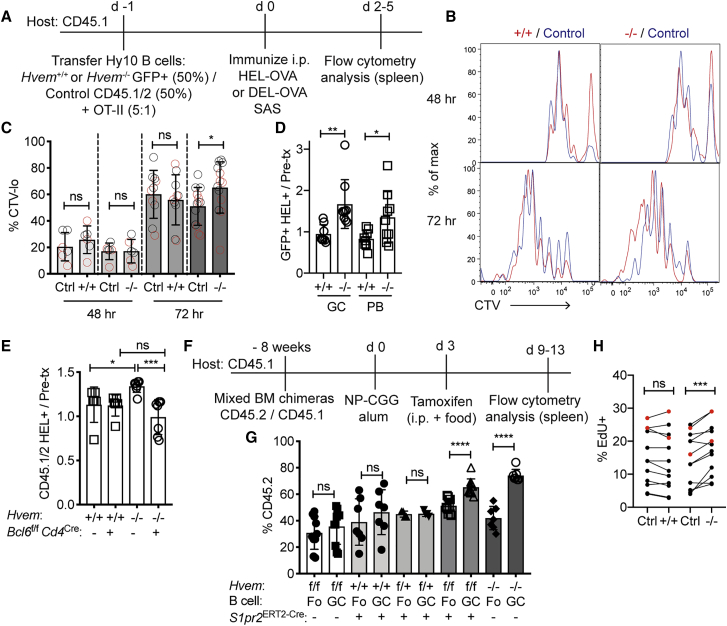
HVEM Deficiency Provides B Cells with a Proliferation Advantage Early in the Response and within the GC(A) Experimental scheme and timeline for experiments in (B)–(D). CD45.1/2 indicates cells from mice carrying both a CD45.1 and a CD45.2 allele. SAS indicates Sigma Adjuvant System.(B) Representative CTV dilution at 48 and 72 hr of Hy10 B cells compared with co-transferred WT Hy10 B cells after DEL-OVA immunization. Hvem+/+ or Hvem−/− Hy10 is in red, and WT mixing partner (control) is in blue.(C) Frequency of CTV-diluted (defined as more than three divisions at 48 hr and more than four divisions at 72 hr) Hy10 B cells compared with their WT mixing controls. Gray circles indicate HEL-OVA immunization, and red circles indciate DEL-OVA immunization. Data are pooled from three experiments.(D) Ratio of the frequency of GFP+HEL+ GC B cells or PBs at days 4.5–5 after HEL-OVA immunization to the pre-transfer frequency of GFP+HEL+ B cells. Data are pooled from three experiments with pre-transfer mixtures of ∼20%–60% GFP+ cells.(E) Mixed Hy10 transfer with endogenous T cell response into Bcl6f/fCd4Cre hosts and 2×-HEL SRBC immunization. The ratio of the frequency of CD45.1/2 Hvem+/+ or Hvem−/− Hy10 to the pre-transfer frequency is shown. Tfh-cell-deficient (Bcl6f/fCd4Cre) and control hosts were analyzed at days 5–7. Data are pooled from three experiments.(F) Experimental scheme and timeline for experiments in (G).(G) Frequency of CD45.2 Fo and GC B cells in the tamoxifen-treated mixed BM chimeras. Data are pooled from three experiments and include chimeras with 10%–60% CD45.2 Fo B cells.(H) Frequency of EdU+IgDloEphrinB1+ GC B cells in Hvem+/+ and Hvem−/− mixed BM chimeras immunized with NP-CGG. Animals were treated with EdU 1 hr before analysis at day 6 or 7 (black circles) and day 21 (red circles). Data are pooled from three experiments.Unpaired two-tailed Student’s t test (C–E and G) or paired two-tailed Student’s t test (H): ∗p < 0.05, ∗∗p < 0.01, ∗∗∗p < 0.001, ∗∗∗∗p < 0.0001. See also Figure S2.